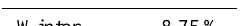
Probability of p d = 0